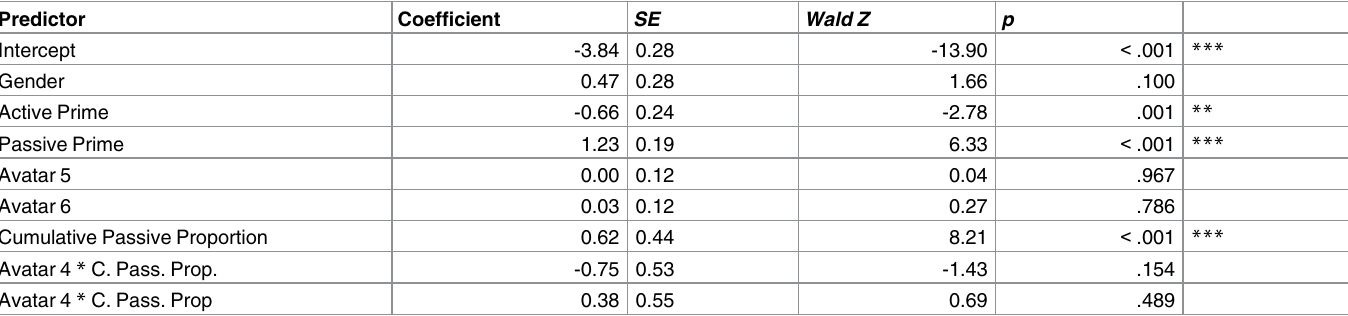
Table 3. Summaryof the fixed effectsin the mixed logit model for the response choices based on prime structure per avatartype.